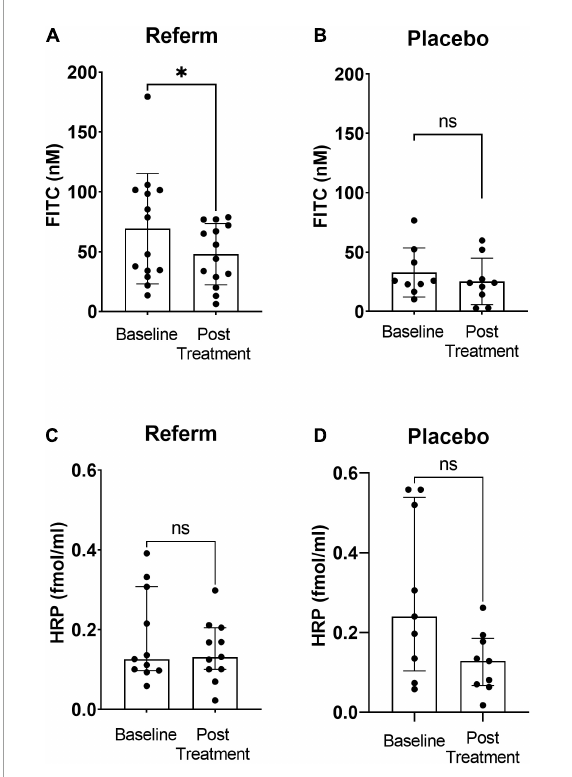
FIGURE3 Effects of fermented oat gruel (ReFerm R (cid:13) ) or placebo on the intestinal permeability of patients with irritable bowel syndrome (IBS). Patients with IBS were allocated to the ReFerm R (cid:13) arm ( n = 18) or the placebo arm ( n = 12). Biopsies were collected at baseline and after the intervention. (A) Paracellular permeability to fluorescein isothiocyanate (FITC)-dextran 4,000 decreases significantly after ReFerm R (cid:13) intervention ∗ p < 0.05. (B) Placebo intervention does not alter the paracellular permeability not significant (ns). (C) ReFerm R (cid:13) intervention does not affect the transcellular permeability to horseradish peroxidase (HRP). (D) Placebo intervention does not affect the transcellular permeability. Data are presented as the median and interquartile range (IQR). n , number of